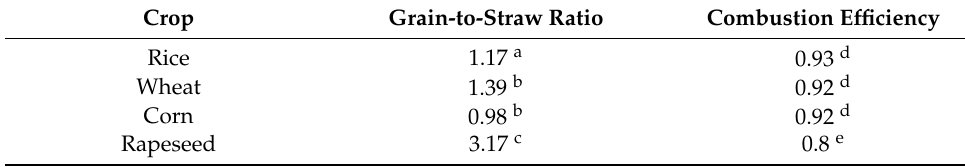
Table 2. Parameters used in the calculation of residue resources burned in the open field. Crop Grain-to-Straw Ratio Combustion Efficiency Rice 1.17 a 0.93 d Wheat 1.39 b 0.92 d Corn 0.98 b 0.92 d Rapeseed 3.17 c 0.8 e